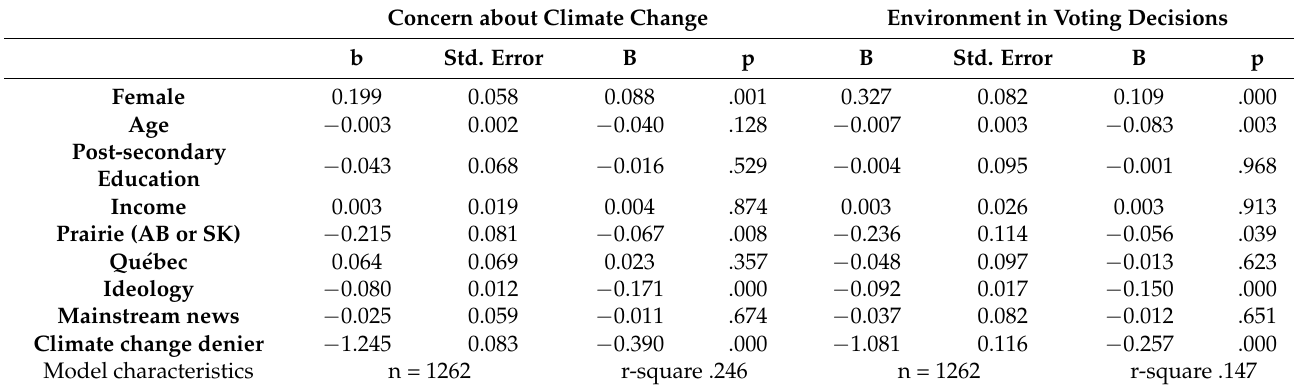
Table 2. OLS regression on concern about climate change and the environment in voting